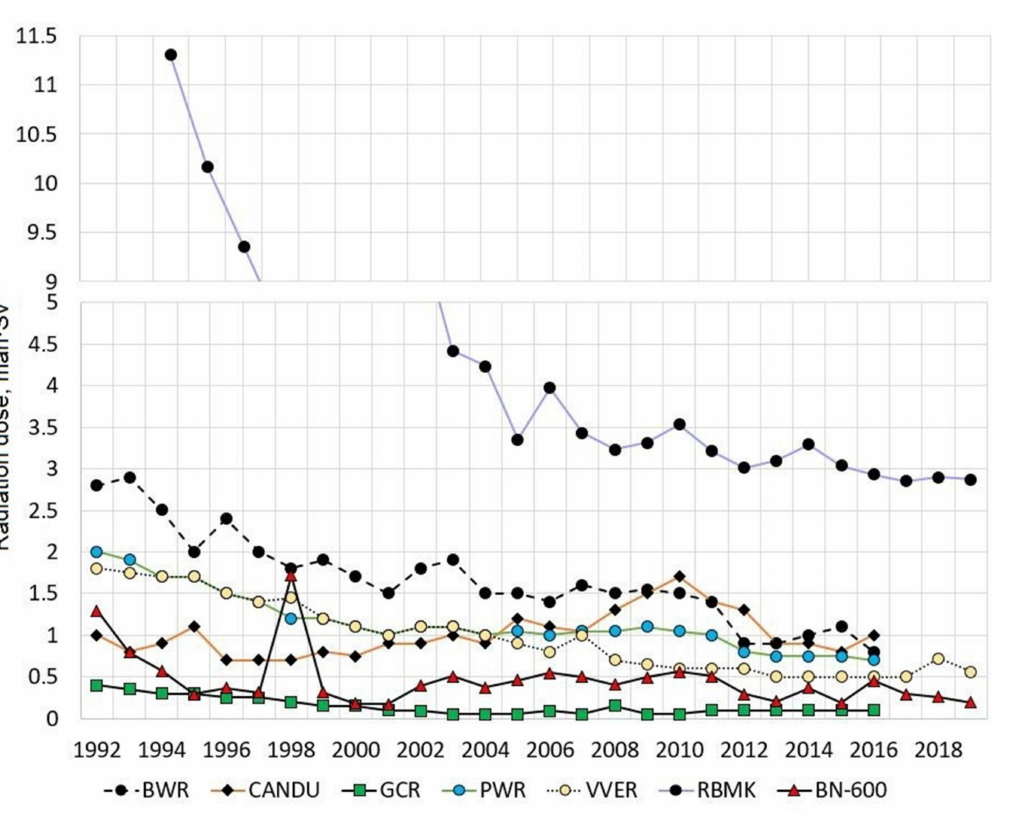
Figure 1. Annual collective doses averaged per power